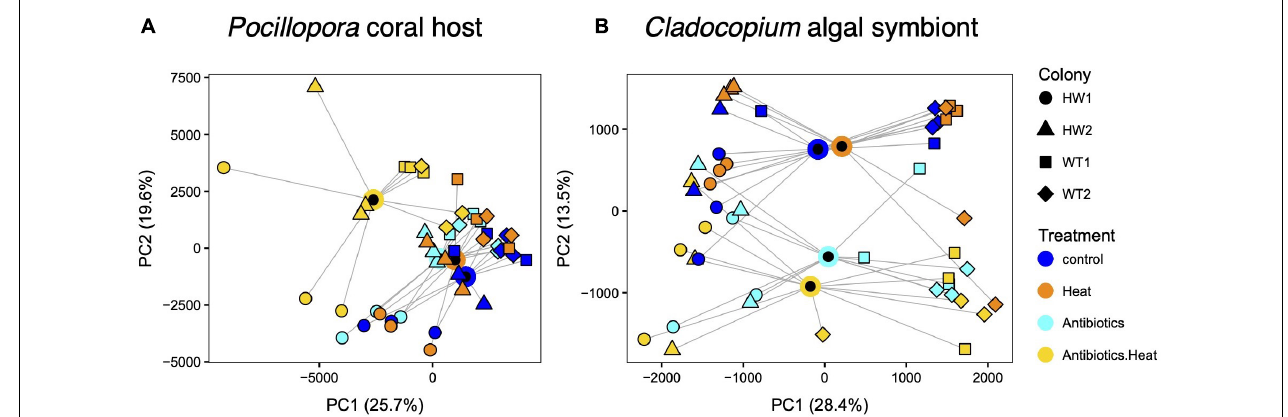
FIGURE 2 | Principal coordinates analysis (PCoA) of transcriptome patterns in (A) Pocillopora corals and (B) Cladocopium algal symbionts reveals coral host cryptic species variation and experimental treatment effects, including a synergistic effect of combined antibiotics-heat treatment on coral host and algal symbiont gene expression. Point shape represents the sample colony (genotype) and color represents the treatment, with blue for the control treatment, orange for the heat treatment, cyan for the antibiotics treatment, and yellow for the combined treatment. Treatment centroids are plotted as black circles outlined in each treatment color with lines connected to each sample within the